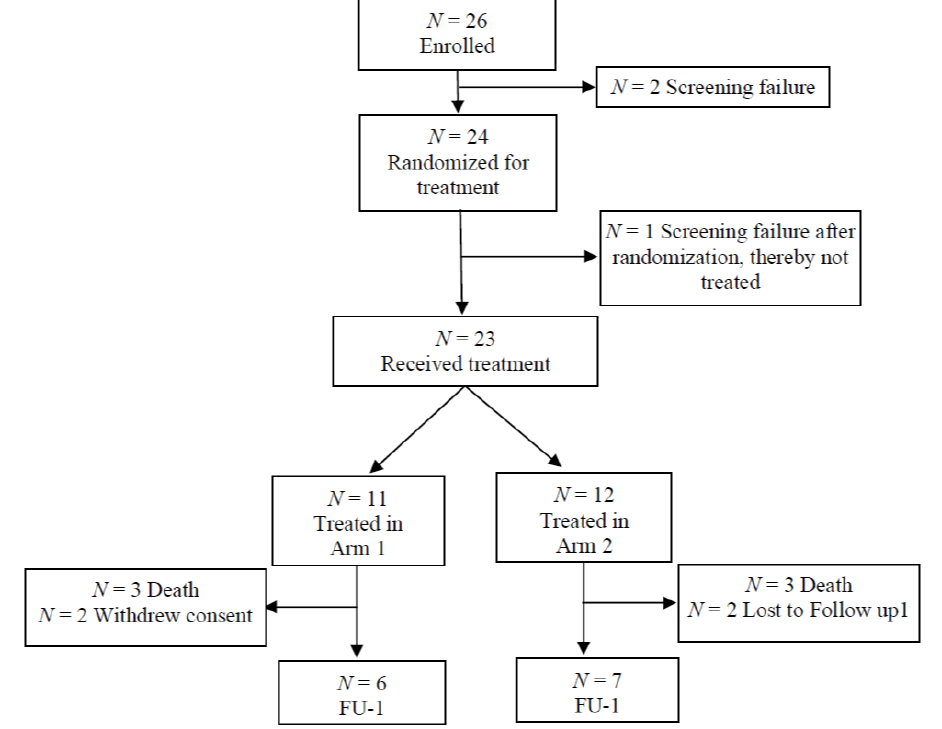
= follow-up period